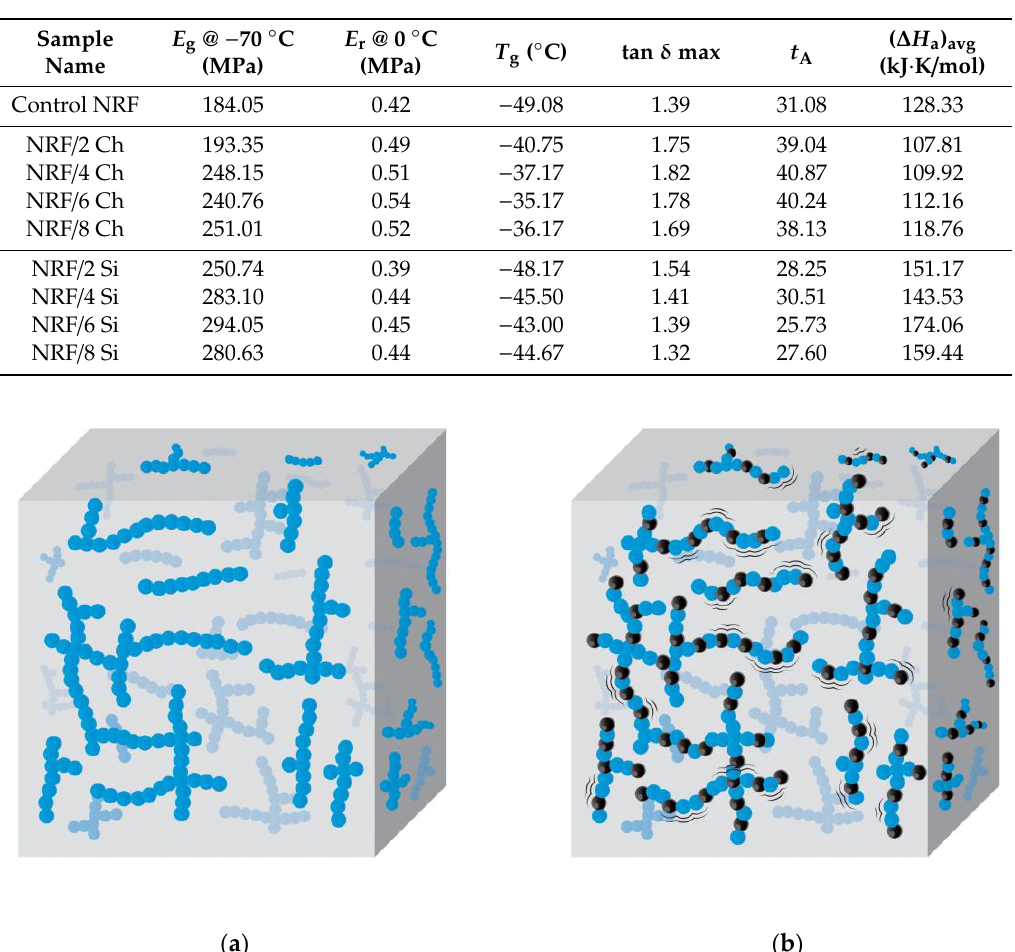
Figure 12. Model of the NRF with rubber chains (blue spot) and fillers (black spot): ( a ) control NRF; ( b ) NRF with filler, which increases the volume fraction of filler ( ∆ V f ) induces more stress relaxation ( ∆ S t), resulting in a more pronounced entropy (∆ S ).